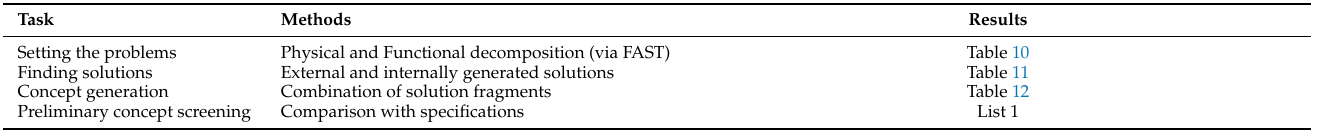
Table 14. Summary of tasks and methods adopted in the Concept generation